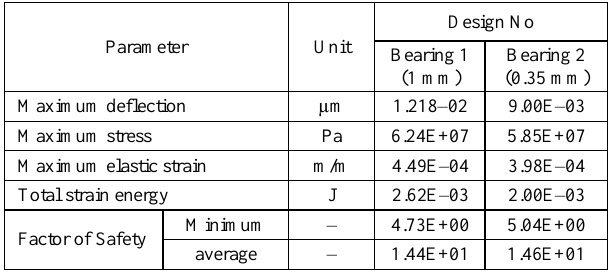
Table 2. Comparison of the results for each